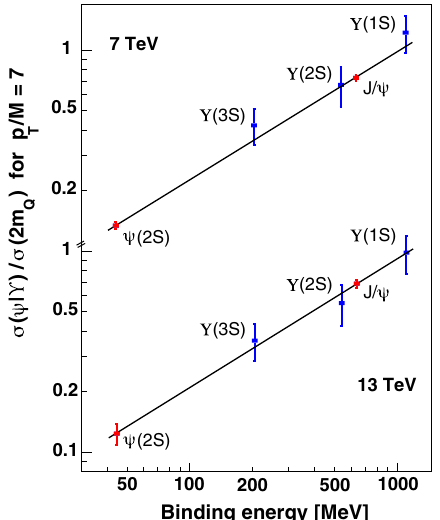
Fig. 1 Direct production cross sections of quarkonia in pp collisions (normalized to the extrapolated cross section of a state of mass 2 m Q ), shown as a function of E b at 7 and